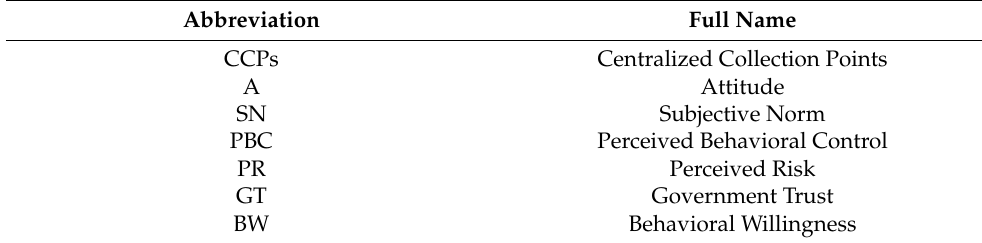
Table 1. List of abbreviations.